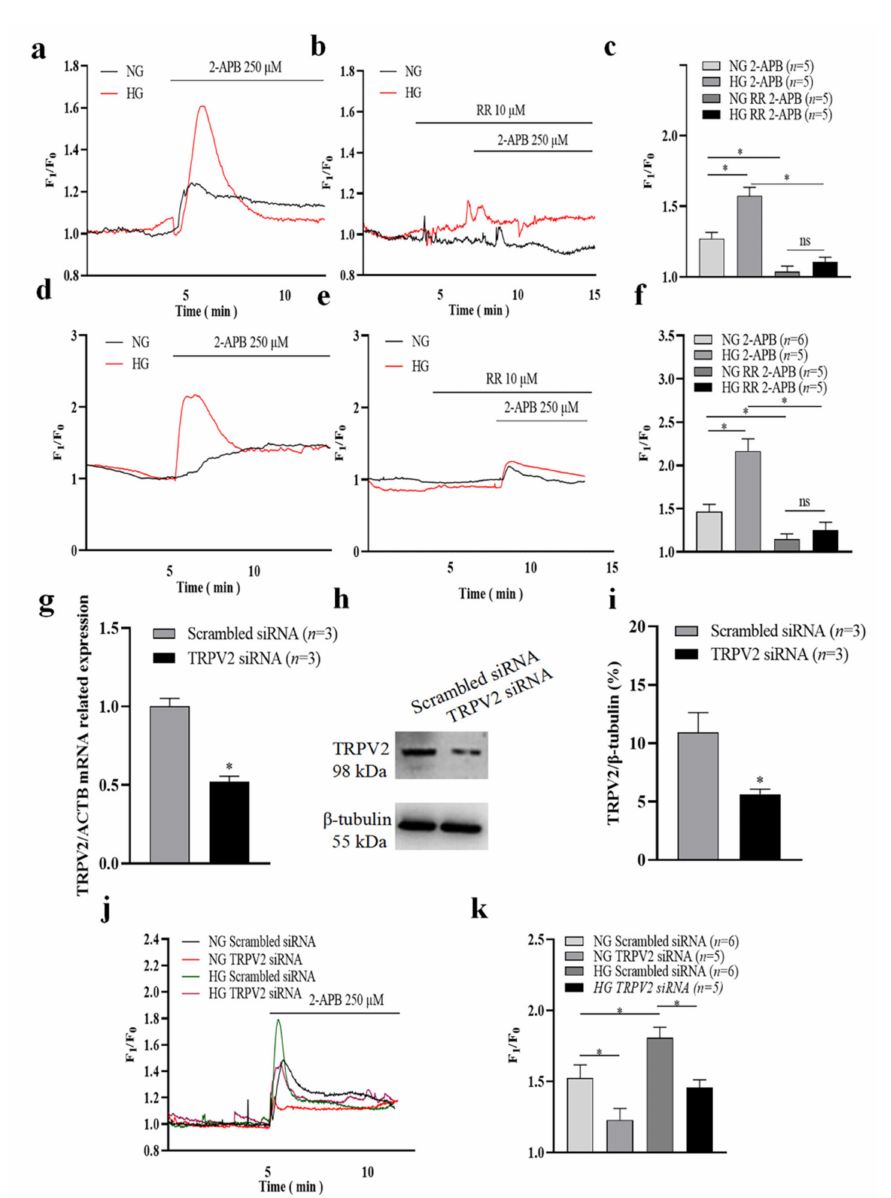
Figure 2. Changes of TRPV2-mediated Ca 2+ influx in a high-glucose environment. ( a – f ) Repre- sentative traces ( a , b , d , e ) and summary data ( c , f ) showing the changes in the intracellular Ca 2+ concentration of HLEpiCs ( a – c ) and primary rat lens epithelial cells ( d – f ) cultured in a normal- glucose (NG, 5.5 mM glucose and 20 mM mannitol) or high-glucose (HG, 25.6 mM glucose) medium for seven days. The cells were treated without or with ruthenium red (RR, 10 µ M) and activated by 2-aminoethyldiphenyl borate (2-APB, 250 µ M). ( g ) Summary data showing TRPV2 mRNA ex- pression level of HLEpiCs transfected with TRPV2 siRNA or scrambled siRNA control for three days. ( h – i ) Representative Western blotting images ( h ) and summary data ( i ) showing TRPV2 protein expression levels of HLEpiCs transfected with TRPV2 siRNA or scrambled siRNA control for three days. ( j – k ) Representative traces ( j ) and summary data ( k ) of the changes in intracellular Ca 2+ concentration of HLEpiCs transfected with TRPV2 siRNA or scrambled siRNA control and cultured in NG or HG media for seven days. The TRPV2 channel agonist 2-APB (250 µ M) activated the channel to induce Ca 2+ influx. Values are shown as the mean ± SEM; n = 3–6. * p < 0.05 analyzed by two-way analysis of variance followed by a Bonferroni test in panel c , f and k , and two-tailed unpaired Student’s t test in panel ( g , i ); ns, not